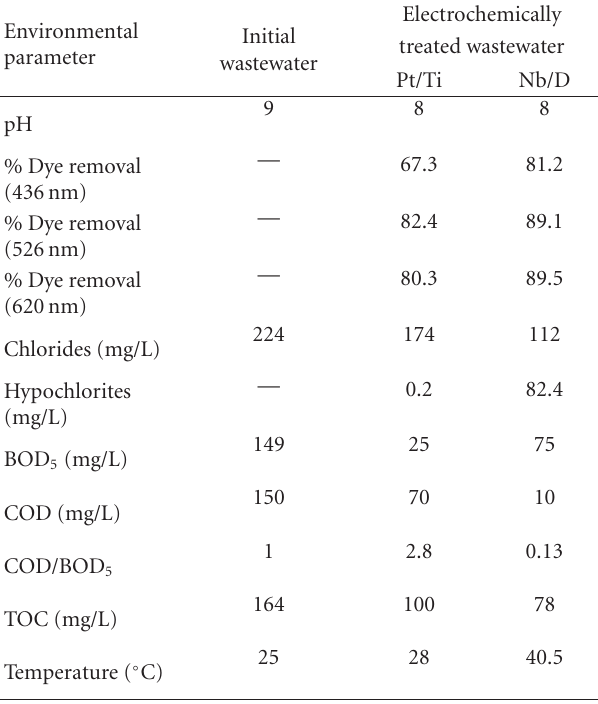
Figure 11: (a) Comparison on degradation performance of di ff erent reaction systems and (b) TOC decay with reference to electrolysis time for the mineralization of X-3B with three di ff erent systems ( C 0 : 50 mg/L, I appl = 25 . 2 mA/cm 2 , pH 2.72) [40]. Table 2: Initial and final values of the most important environ- mental parameters of electrochemically treated wastewater under optimal conditions [48].